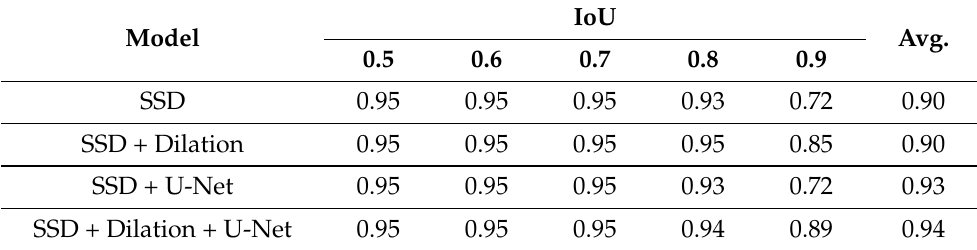
Table 6. The F1-scores in ablation experiment of dilation and U-Net on our